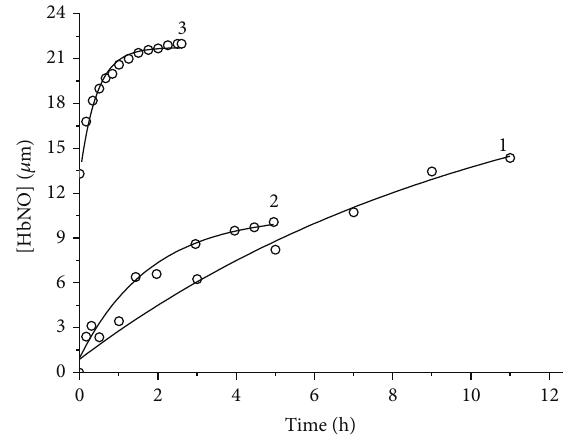
Figure 6: (1) Kinetics of HbNO formation at interaction of ( II ) with Hb on the base of the experimental data shown in (a). (2) Kinetics of HbNO formation at interaction of ( I ) with GSH in Hb presence. Hb on the base of the experimental data shown in (b). (3) Kinetics of HbNO formation in the interaction of ( I ) with Hb, the experimental data shown in (c). Circles are the experimental data. Solid line is the approximation by means of 𝑦(𝑡) = 𝑦 𝑜 + 𝐴 ⋅ (1 − 𝑒 −𝑘𝑡 ) . (Figures a, b, and c are in Supplementary Materials available online at http://dx.doi.org/10.1155/2014/641407). ( II ) is the complex ( SC ) ( NO ) ] SO ⋅ 2 H [ Fe 2 10 H 17 N 3 O 6 4 4 2 2